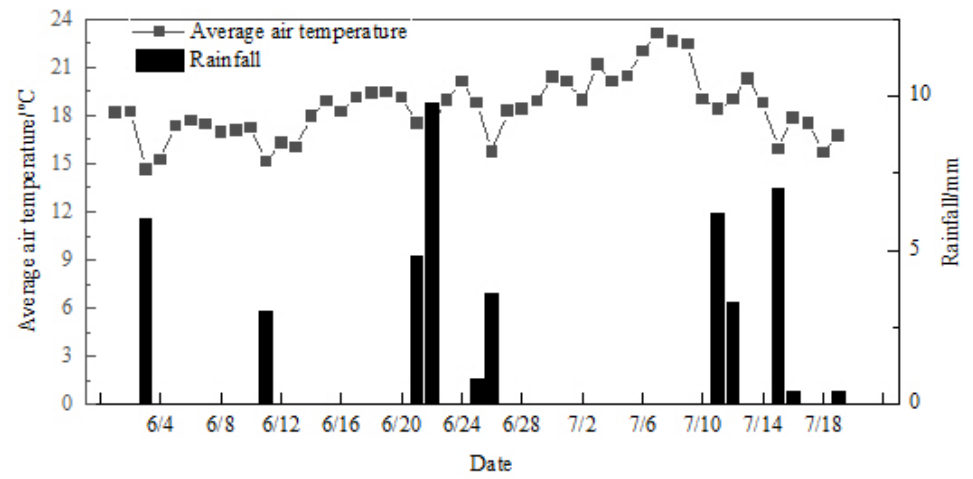
Figure 1. Average temperature and rainfall in the test site from June to August. Small weather stations were set up at the trial site to record local rainfall and temperature data.